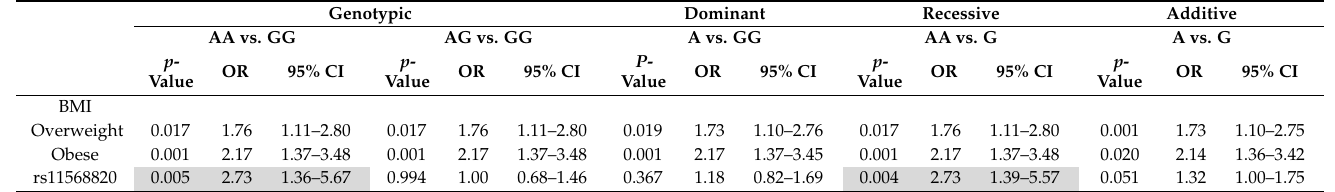
Table 4. Impact of clinical characteristics and Cdx2 (rs11568820) polymorphism on susceptibility to asthma.